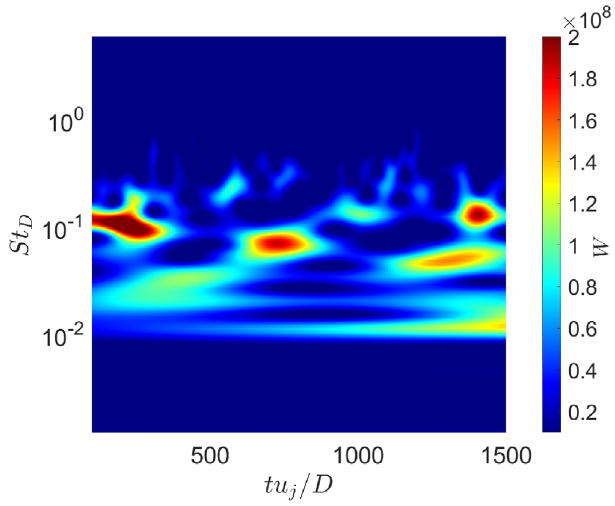
Figure 1. A wavelet scalogram computed from a signal taken at TI = 9%, r / D = 3 and x / D = 10.